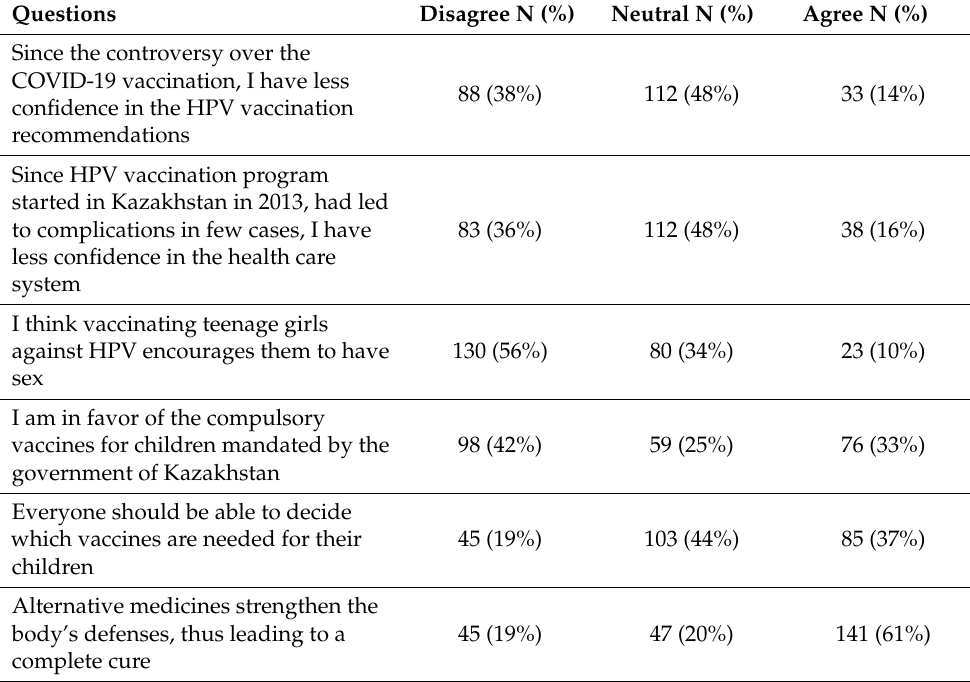
Table 2. Contextual factors, N =